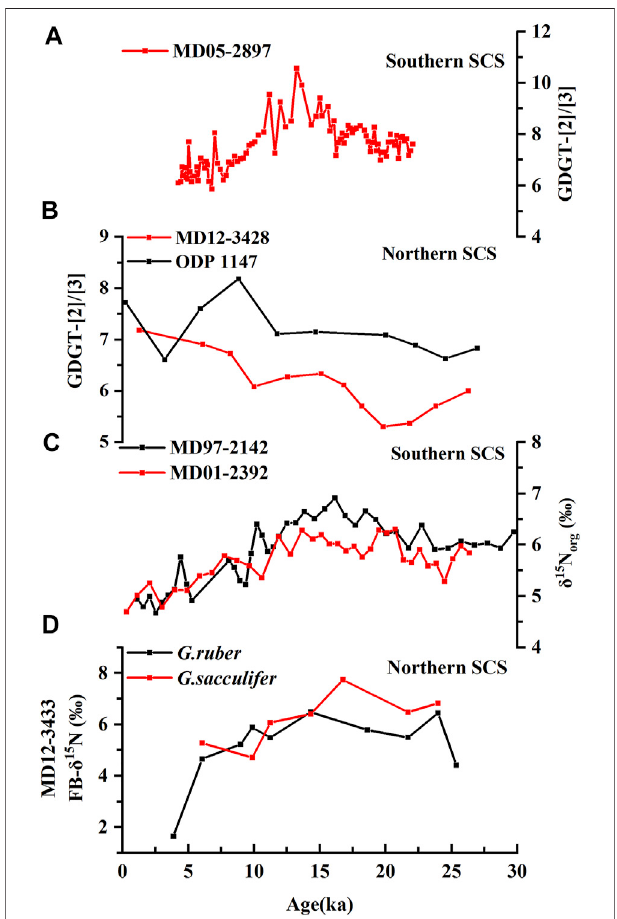
FIGURE2| Comparison of the relationship between nitrogen fi xation and archaeal ammoxidation in the northern and southern SCS since 30 ka. (A) δ 15 N org values of southern cores MD01-2392 (Dong et al., 2019) and MD97-2142 (Ren et al., 2017). (B) Nitrogen isotope FB- δ 15 N of planktic foraminifers in northern core MD12-3433 (Wang et al., 2018). (C) GDGT-[2]/[3] ratio of southern core MD05-2897 (Dong et al., 2015); (D) GDGT-[2]/[3] ratio of northern cores MD12-3428 (Dong et al., 2018) and ODP 1147 (Li et al., 2013).